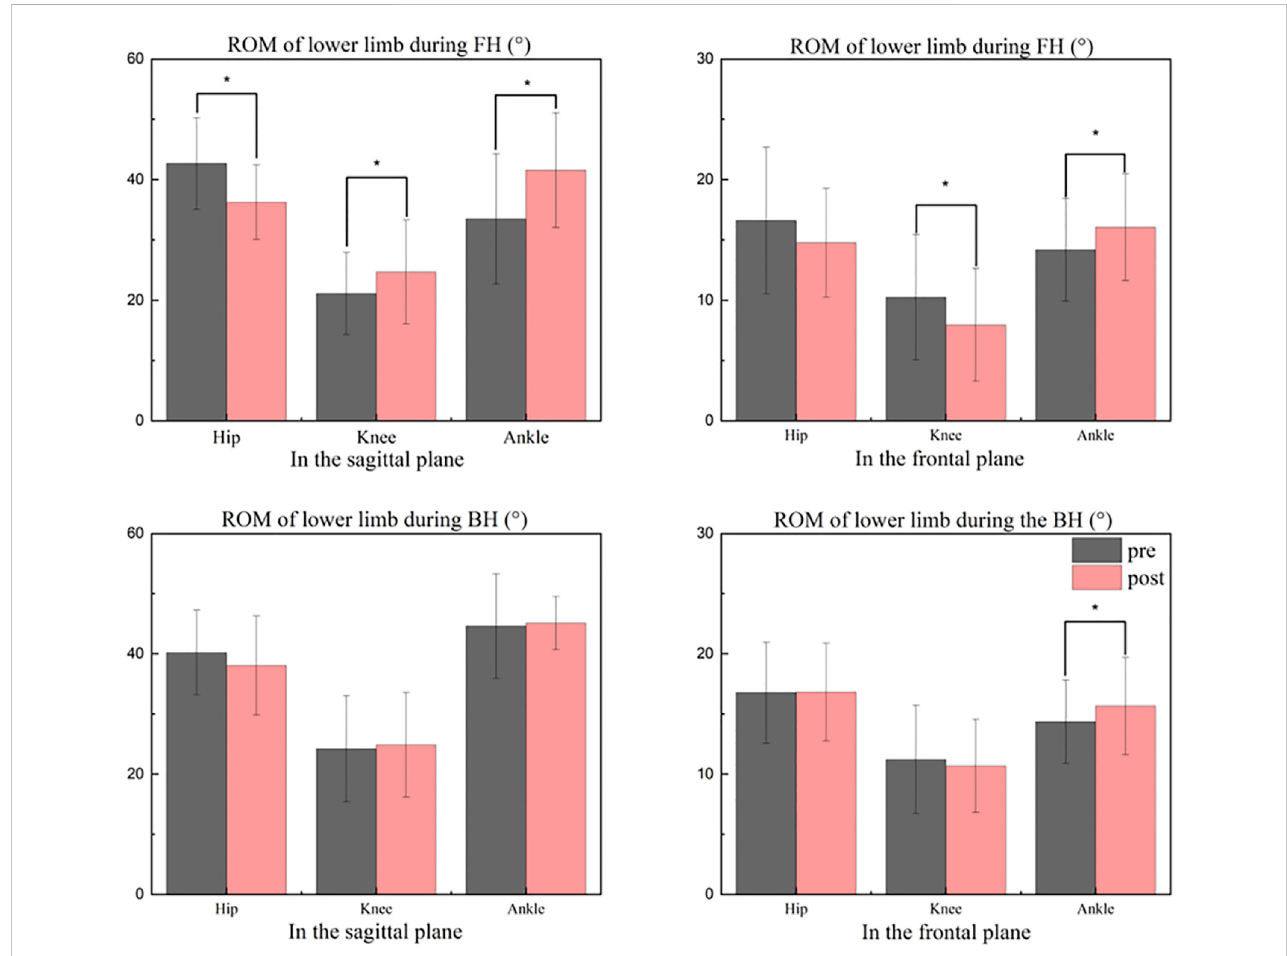
FIGURE 3 Comparisons between pre and after ROM levels during the strike period. FH, forehand lunge; BH, backhand lunge; pre, pre-fatigue, post, post-fatigue. *Signi fi cant differences at the hip, knee, and ankle ( p < 0.05).